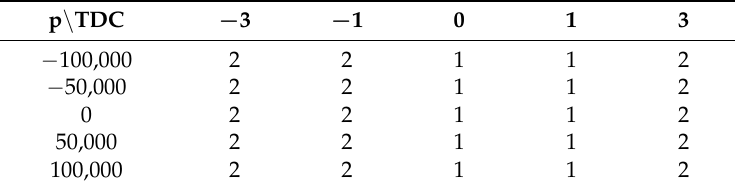
Table B2. Number of iterations for the PSA engine and operating point 2000 1/min and 20 Nm using the off-line method.